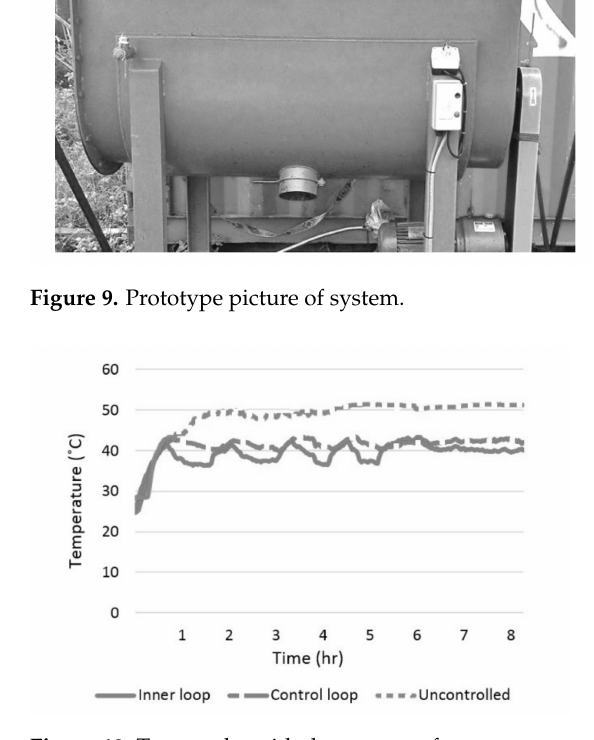
Figure 10. Test results with three types of temperature.